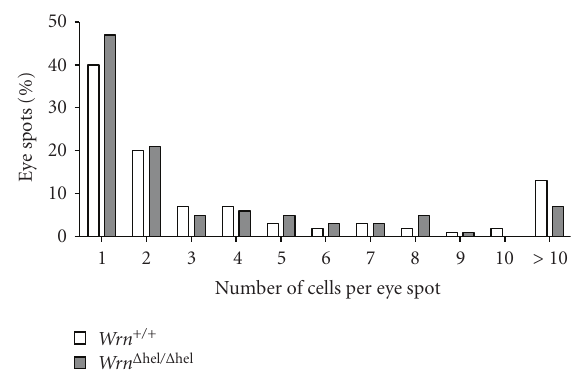
Figure 3: Frequency of the di ff erent sizes of eye spot (number of cells per eye spot) in mouse RPE. Wrn Δ hel / Δ hel (grey boxes) does not a ff ect cell size distribution compared to wild-type (open boxes) ( P = . 39).